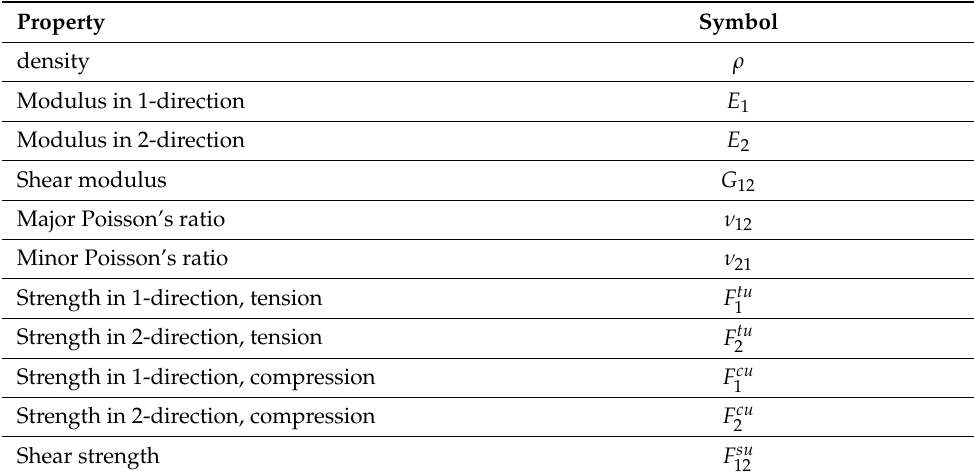
Table 1. Material